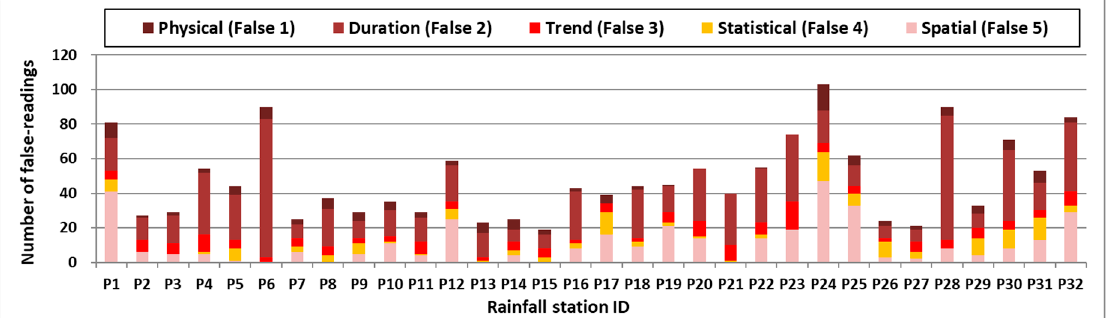
Figure 8. False data validation results of 32 precipitation stations.